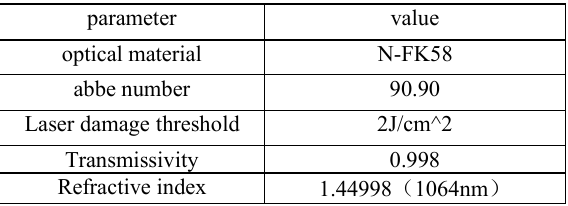
Table 3. N-FK58 Material